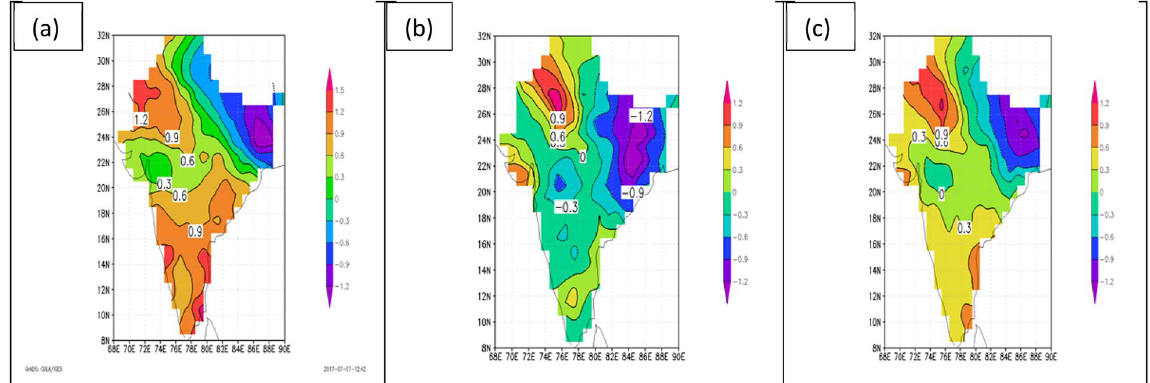
Figure 2. Difference in decade means of daily temperature (C) for the pre-monsoon period of April 1 to May 31. Values are for the decade of the 2000s minus the decade of the 1950s for ( a ) maximum temperature, ( b ) minimum temperature, and ( c ) mean temperature. Figures are generated using GrADS 2.2.0 (http://cola.gmu. edu/grads/).